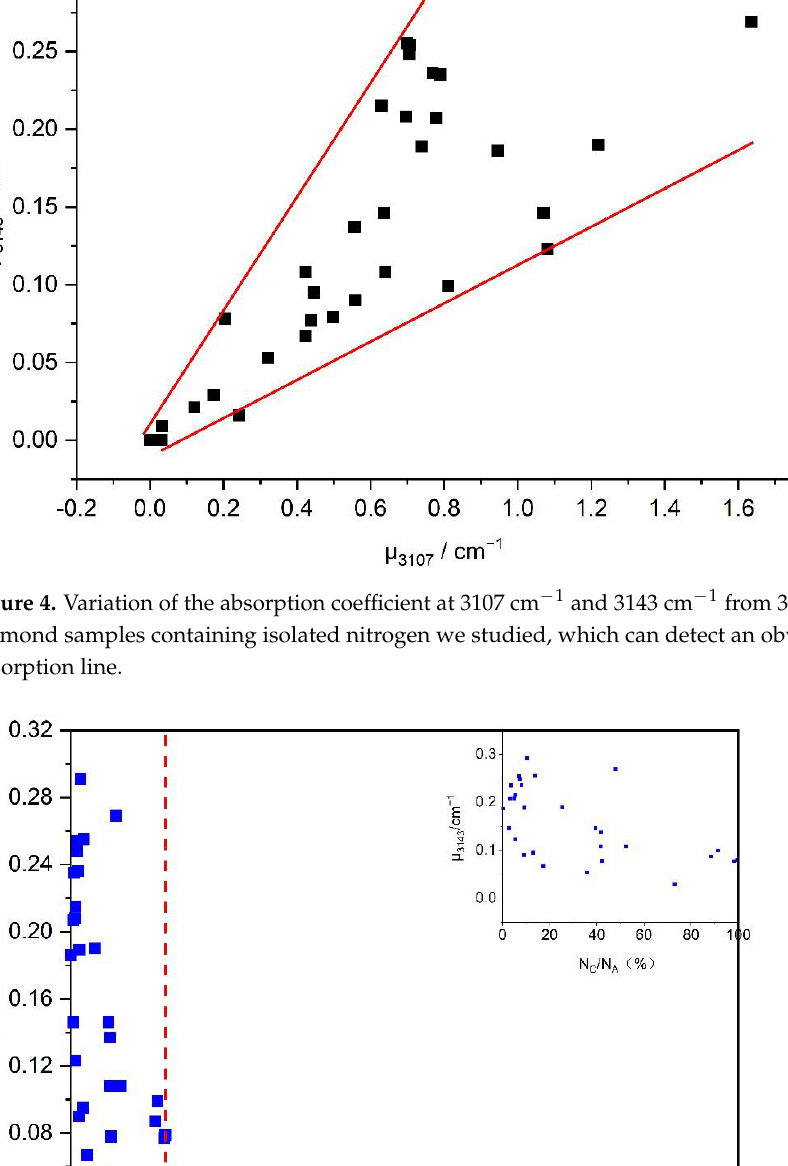
Figure 6. The intensity changes of 3107 and 3143 cm −1 absorption of three natural type Ib diamonds before and after 15 min HPHT-treated process. The 3107 ( a ) and 3143 ( b ) cm −1 absorption peak height increased with the increasing of the annealing temperature. After high-temperature annealing, most noteworthy is the creation of a quite distinct peak at 3157 (3156.8) cm −1 in all three samples (Figure 7). The 3157 cm −1 absorption has never been reported in natural diamonds before, and we just detected it in several natural type IaA diamonds containing very little nitrogen. Hainschwang et al. [23] reported that the 3156 cm −1 peak is related to hydrogen and produced under HPHT annealing condi- tions in the FTIR spectra of CO 2 and “Pseudo-CO 2 ” diamonds. Compared with the 3157 cm −1 in this article, they may indicate the same defect.